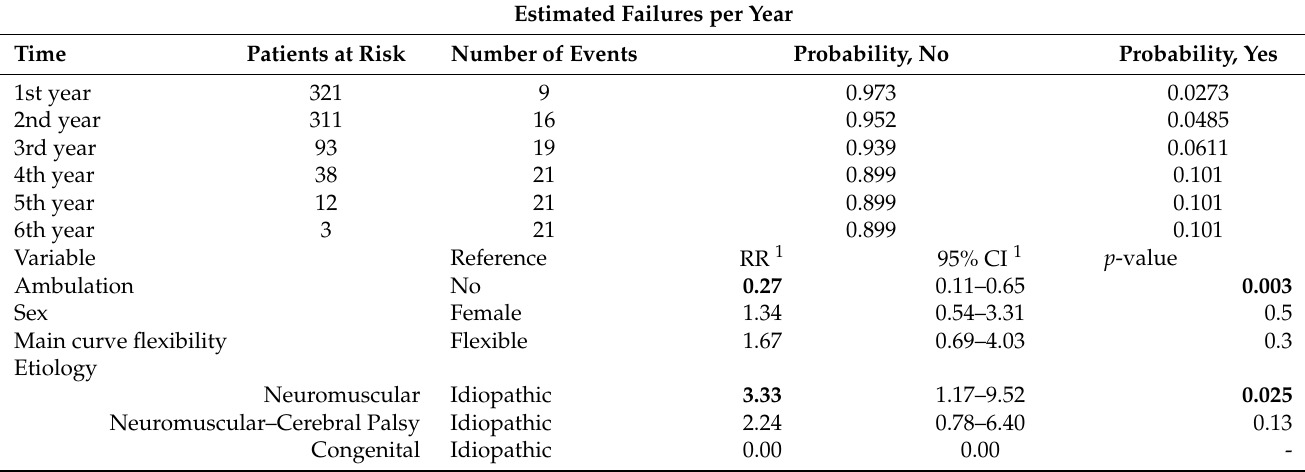
Table 6. Risk of failure per year of follow-up and Cox regression according to follow-up time, material failure, ambulation, sex, main curve, flexibility and